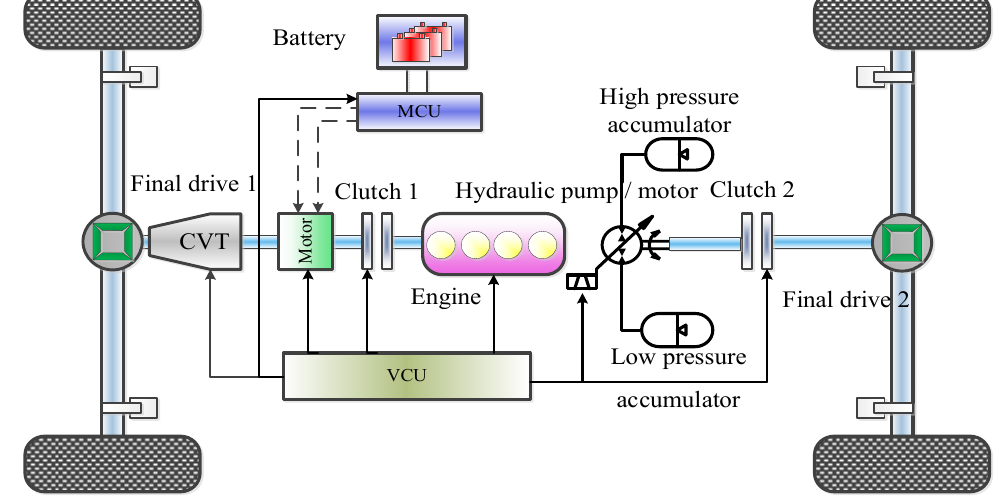
Figure 1. Structure of oil–electric–hydraulic hybrid power system. Table 1. Working modes of the hybrid system.